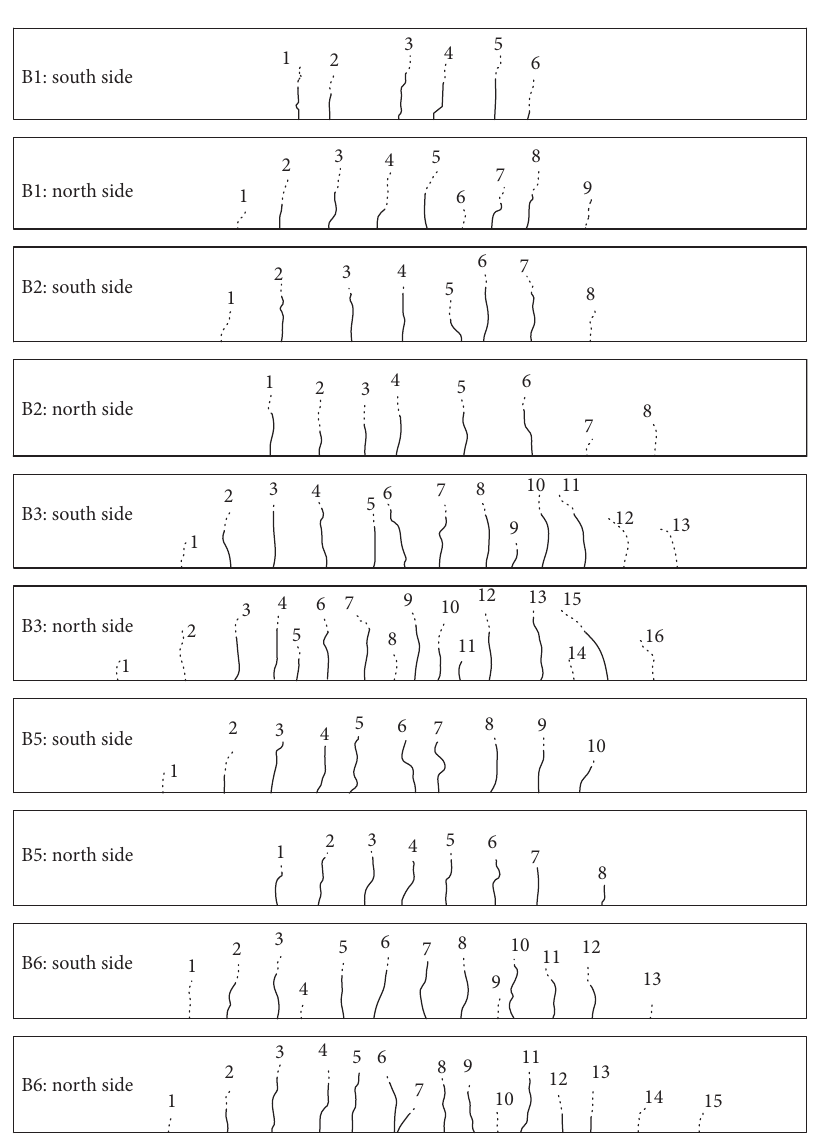
Figure 5: Cracking patterns of the test beams (solid lines � 1st stage; dotted lines � 2nd